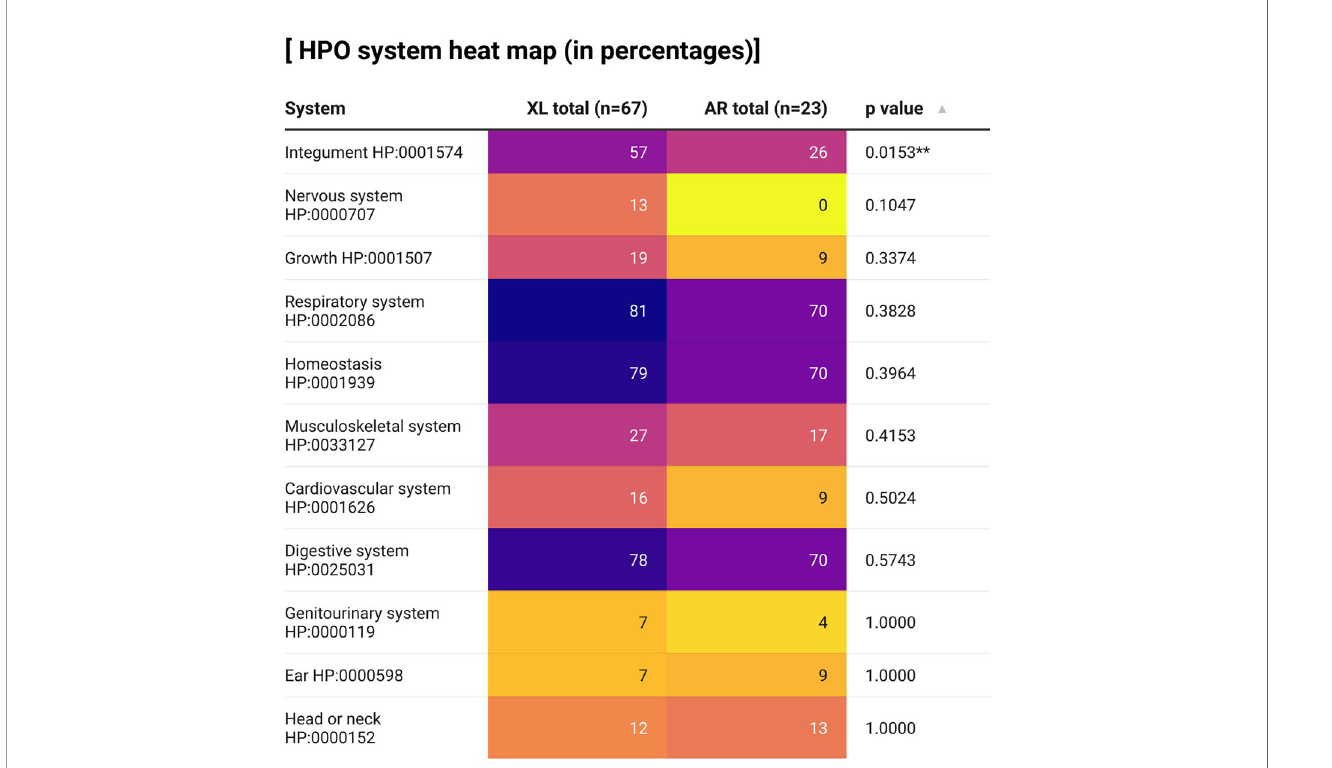
FIGURE 4 | A heat map describing percentages of CGD patients in our case series in which their organ systems are affected. HPO, Human Phenotype Ontology. ** p < 0.01. This graph is created by using the app